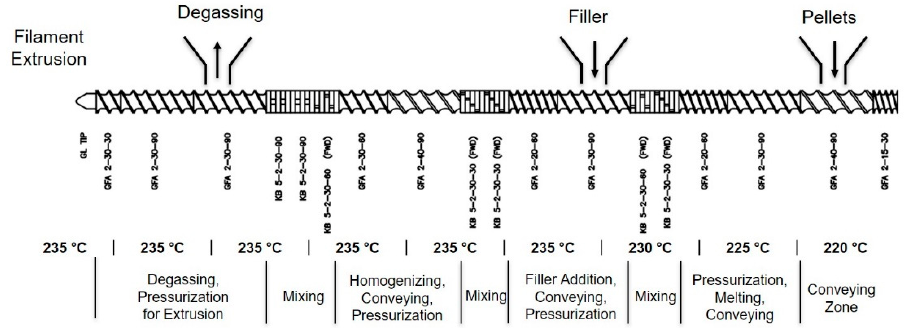
Figure 1. The screw configuration included two mixing zones for compounding the fillers.